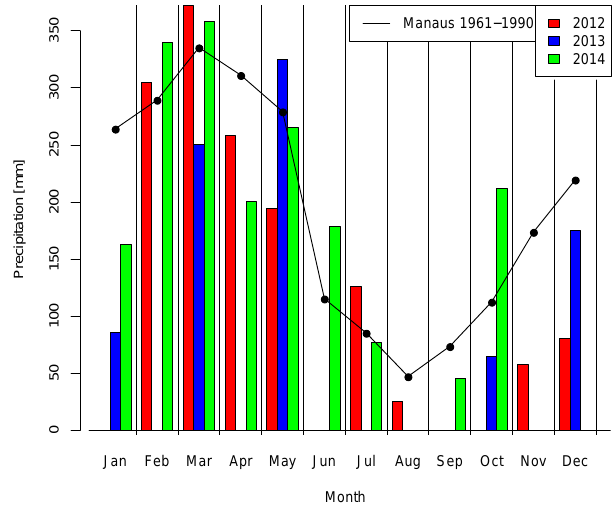
Figure 9. Monthly sums of precipitation at the ATTO site for the years 2012 to 2014. For comparison the data from the Manaus INMET-station (www.inmet.gov.br) for the standard reference pe- riod (1961–1990) are